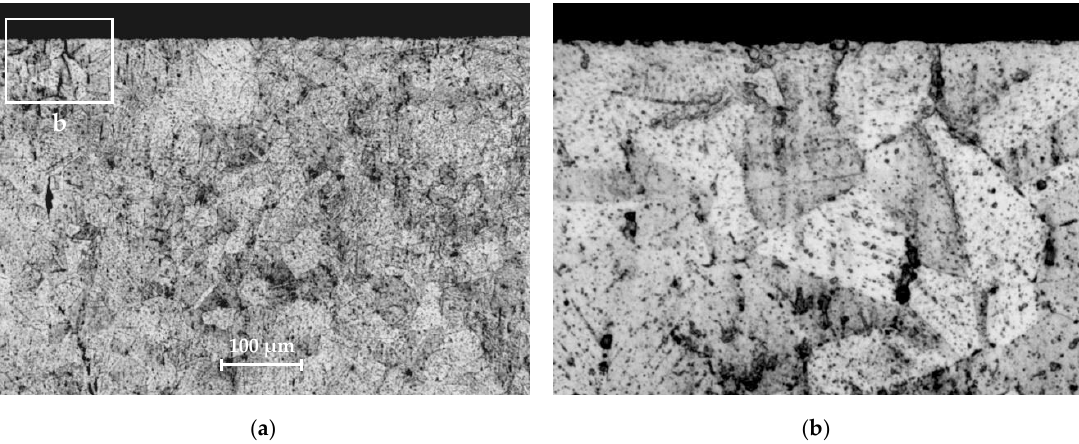
Figure 4. Microstructure of 1.4301 steel: ( a ) general view; ( b ) enlarged marked area.